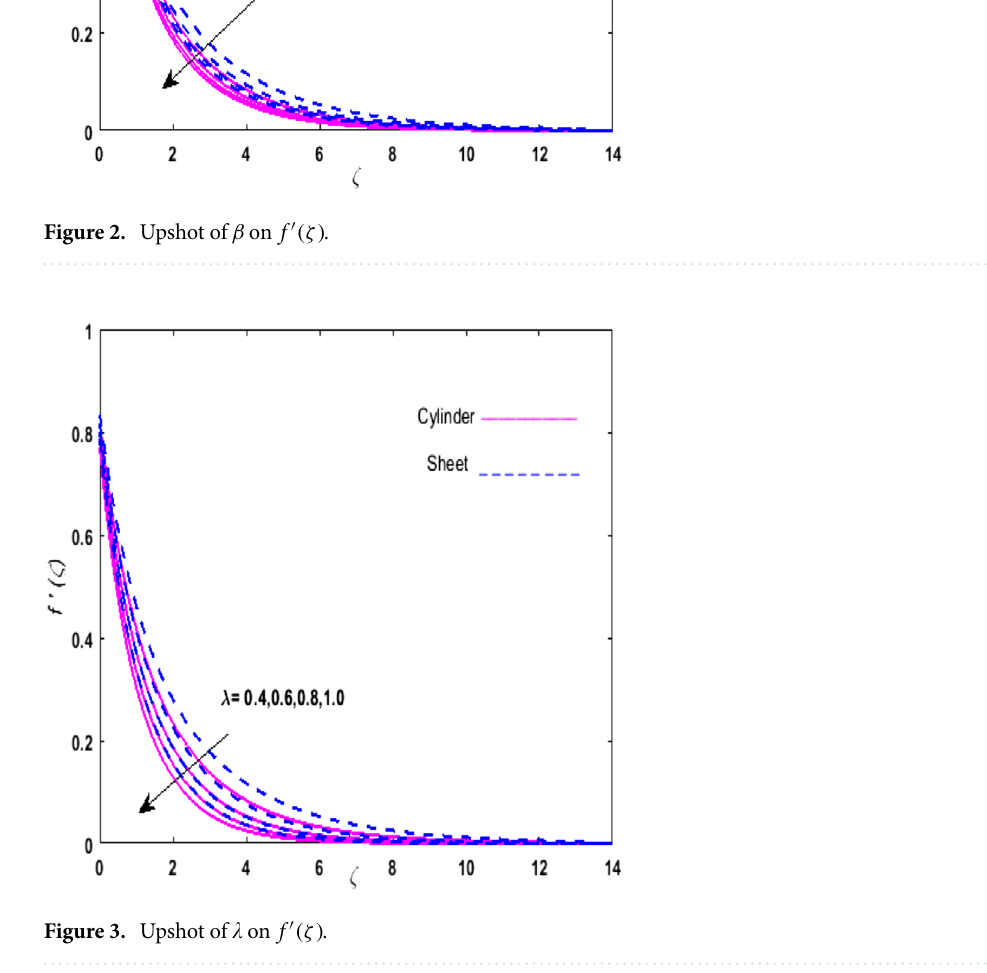
dotted lines for the case of deformable surface which are portrayed in Figs. 2, 3, 4, 5, 6, 7, 8, 9, 10, 11, 12, 13, 14, 15, 16 and 17. Figures 2, 3, 4, 5 and 6 demonstrate the influence of the Casson fluid parameter β , velocity slip parameter L , porosity parameter (cid:31) , curvature parameter ω , and magnetic parameter Ha on the velocity of the fluid f ′ (ζ) . The aftermath of β on velocity field is illustrated in Fig. 2. As β is inversely proportional to yield stress S y . It is found that on escalating β yield stress decreases. This generates a resistive force that causes hindrance to the fluid flow. Consequently, a decreasing trend is perceived in the f ′ ( ζ ) for both the stretchable cylinder and deforming sheet. The variation of the porosity parameter (cid:31) on the fluid flow is presented in Fig. 3. Since (cid:31) is the quotient of kinematic viscosity to the permeability of the porous medium. Growing values of (cid:31) escalates the kinematic viscosity of the fluid. This accelerates the resistance in the system. It is found that on elevating (cid:31) a deterrence is witnessed to the motion of the fluid. Due to mounting values of (cid:31) , sponginess in the medium reduces. Hence, f ′ (ζ) diminishes for both the cylinder and the sheet. The impact of the velocity slip parameter L on f ′ (ζ) is sketched in Fig. 4. As growing values of L strengthens the friction force. Thus, more liquid slips past the deforming cylinder. Therefore, fluid velocity depreciates in both cases for rising values of L . Hence, the behavior of the curvature parameter ω on the fluid flow is represented in Fig. 5. It is noticed that on uplifting the